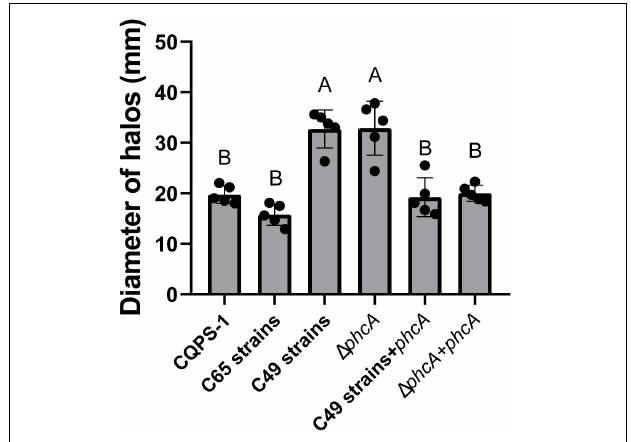
FIGURE 6 | Swimming motility of the acid-evolved clones, the (cid:49) phcA mutant, the control strains, and the original strain CQPS-1. Swimming motility assays were performed on MM medium semi agar (0.3%) plates (MSA medium) supplemented with 20 mM L-glutamate. Swimming halos observed after 72 h incubation at 30 ◦ C. The selected 5 “acid-evolved clones” and 5 “C65 control clones” were used as the C49 strains and C65 strains, respectively. Different letters indicated significant difference as determined by Tukey’s HSD (uppercase difference p -value <